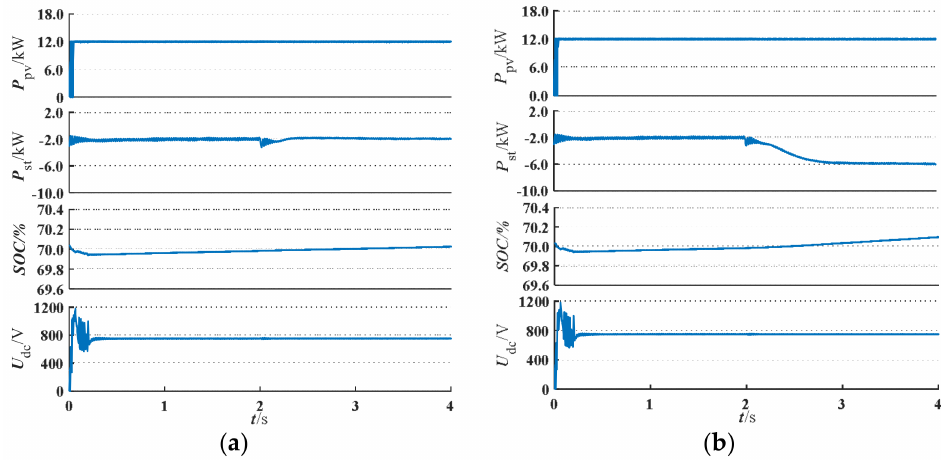
Figure 19. ( a ) Internal state quantities of traditional PV storage in the generator mode; ( b ) Internal state quantities of PV storage virtual synchronous generator system in the generator